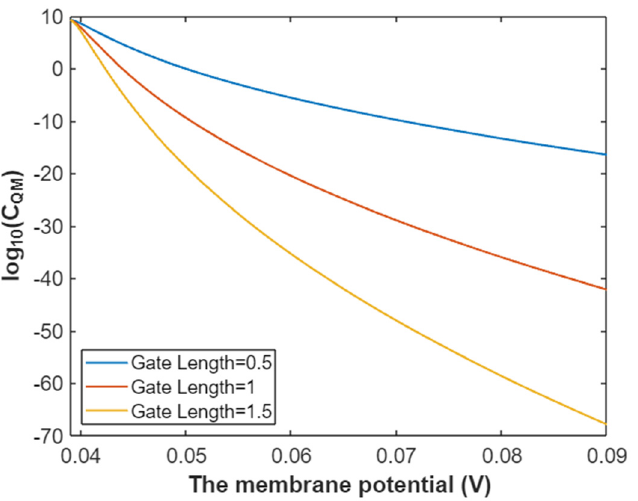
Figure 30. The relationship between membrane potential and the common logarithm of the quantum membrane conductance of intracellular potassium ions at G = 5.35 J and over a membrane potential range from 0.039 V to 0.09 V.